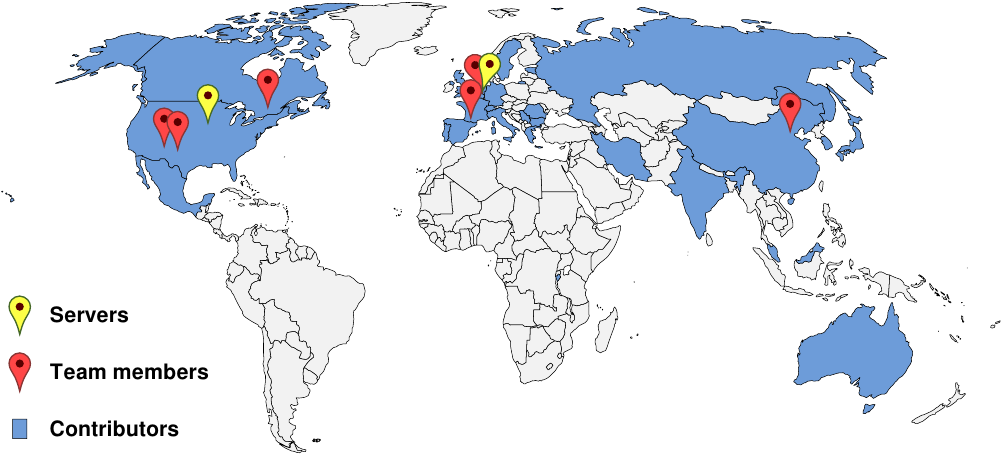
Figure 2. Geographic location of the countries currently contributing to the LXCat project. Please note that this map reflects on the location of direct contributors to the project and not necessarily on the countries from which the data originally came from.